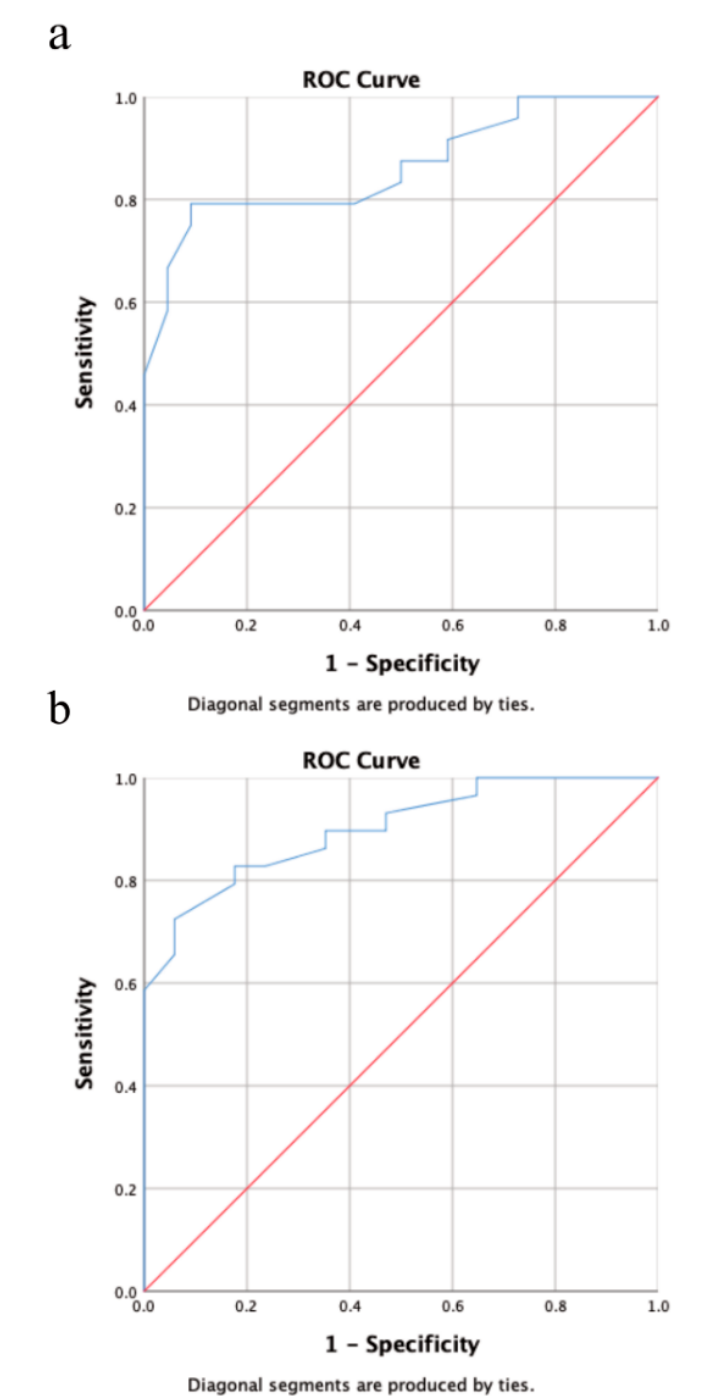
Figure 2. Receiver operating characteristic (ROC) analysis showing the predictive value for primary tumor size for RAI-R TC at initial diagnosis ( a ) and during the course of disease. ( b ) Using area under curve (AUC) as a metric primary tumor size was an excellent predictor for RAI-R TC at initial diagnosis (AUC = 0.86) and during the course of disease (AUC = 0.90). Table 4. ( a ) Multivariate model of risk factors for RAI-R TC at initial diagnosis. ETE = extrathy- roidal extension; CI = confidential interval. ( b ) Multivariate model of risk factors for RAI-R TC during the course of disease. ETE = extrathyroidal extension; CI = confidential interval.